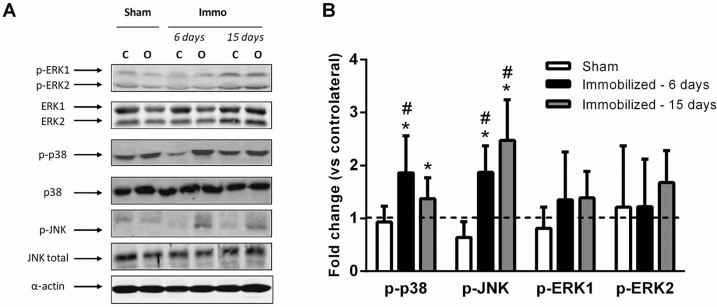
Activation of MAP kinases in skeletal muscle during immobilization.A Representative Western blot for phosphorylated and total ERK, p38, and JNK MAPK. B The MAP kinases phosphorylation in sham, 6- and 15-days immobilized PL were expressed relative to the contralateral muscle (n = 4 animals in each condition). C, contralateral; O, operated. Dashed line represents the basal levels in contralateral skeletal muscle. Error bars represent the SD. * MAPK activation significantly different from contralateral muscles (P < 0.05), # fold-change significantly different from sham-operated group (P < 0.05).